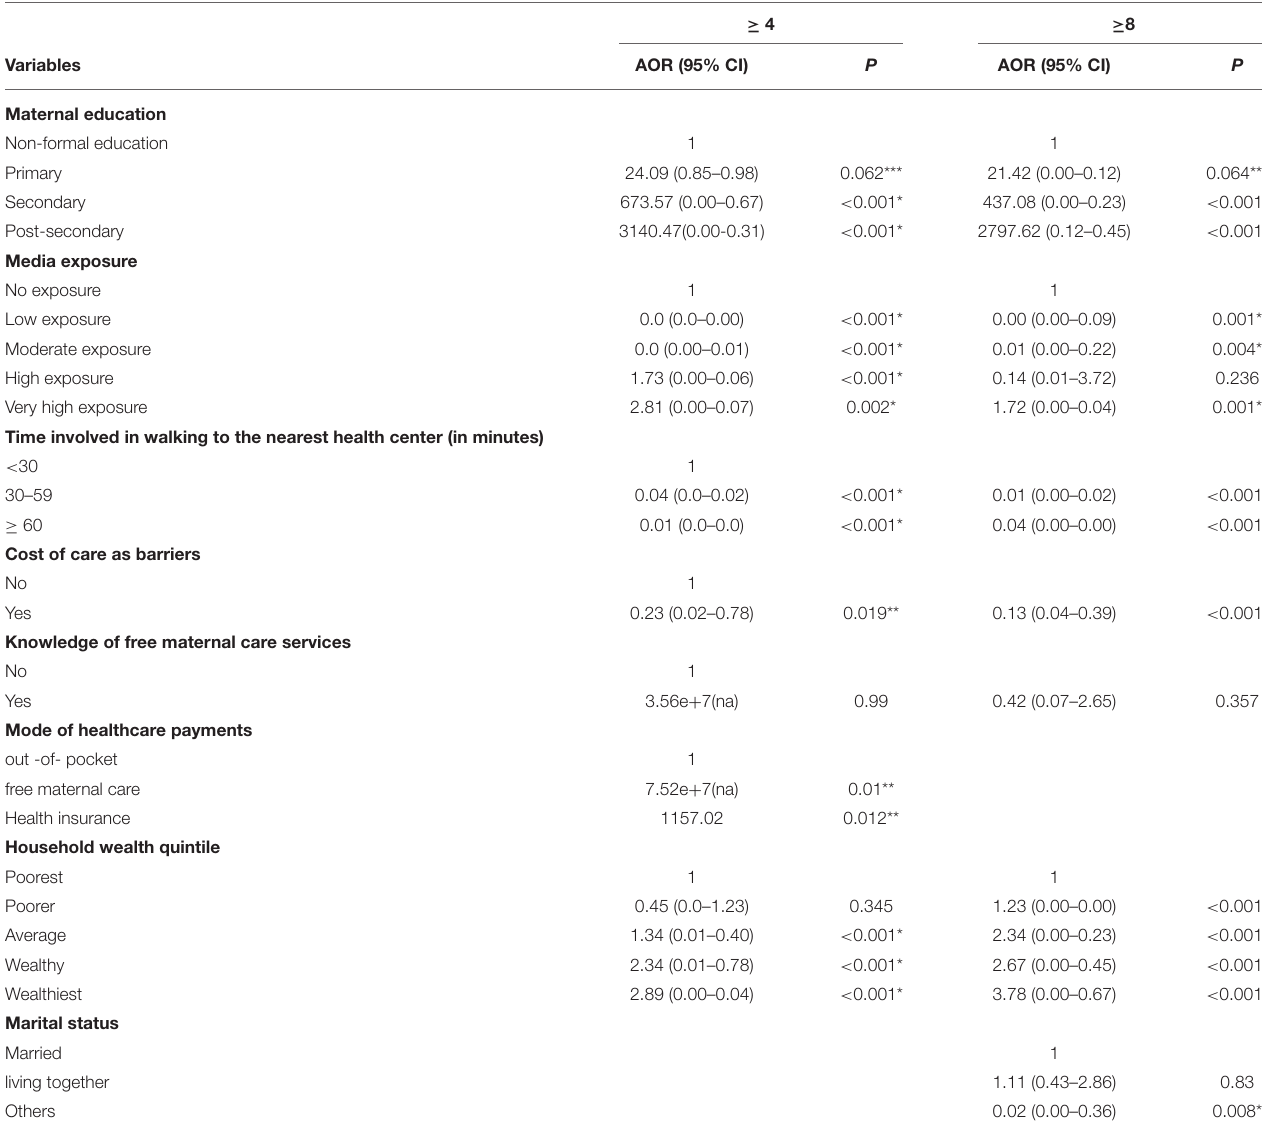
TABLE 3 | Logistic regression of determinants of antenatal care contacts among women in household